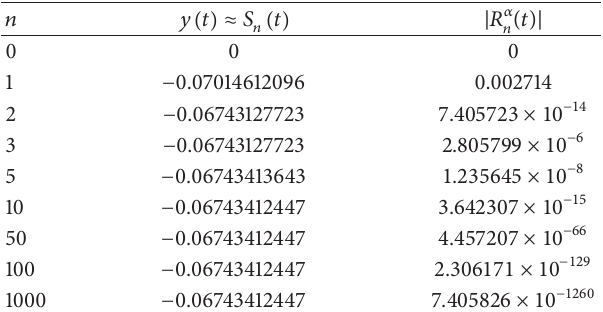
Table 10: 𝑆 𝑛 (𝑡) values in Example 4 for 𝛼 = 0.9 , 𝑡 = 0.05 .